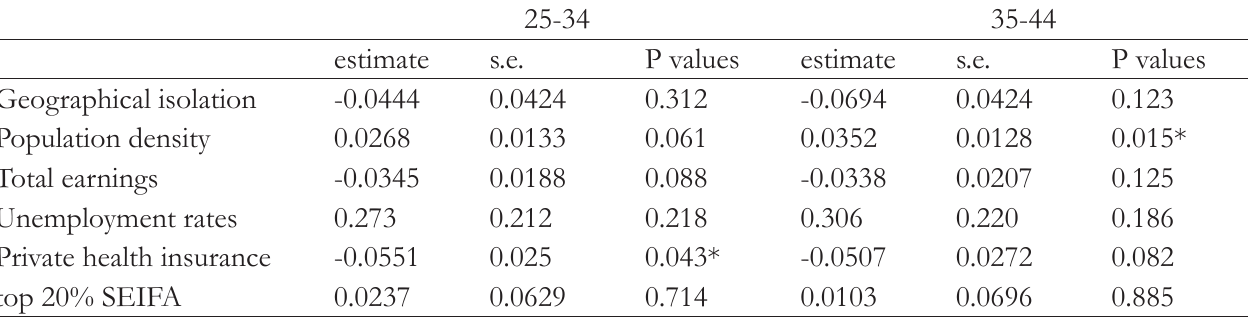
Table 2. Regression analysis results of effect of socio-economic factors for women in two age groups: 25